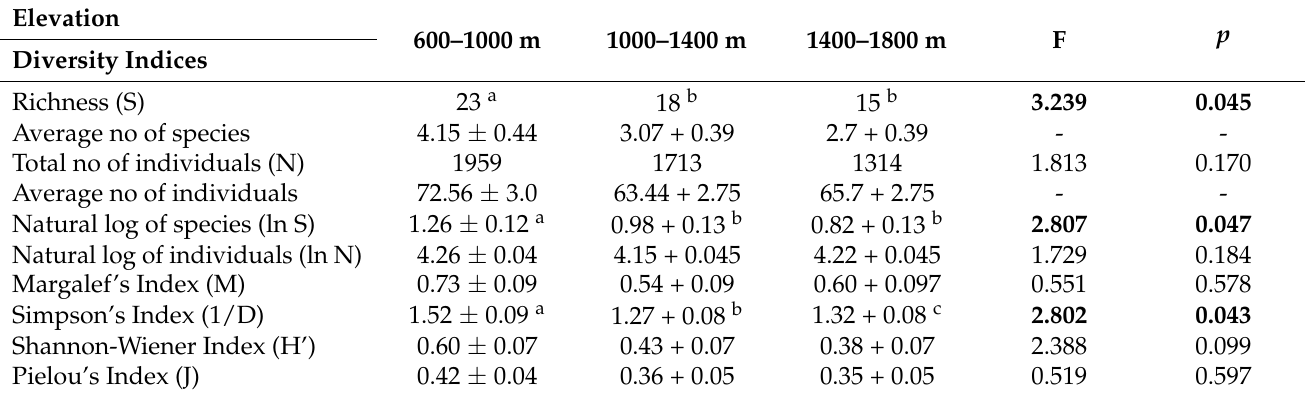
Table 2. Species richness and diversity indices for the woody tree species in Monotheca forests communities across elevation